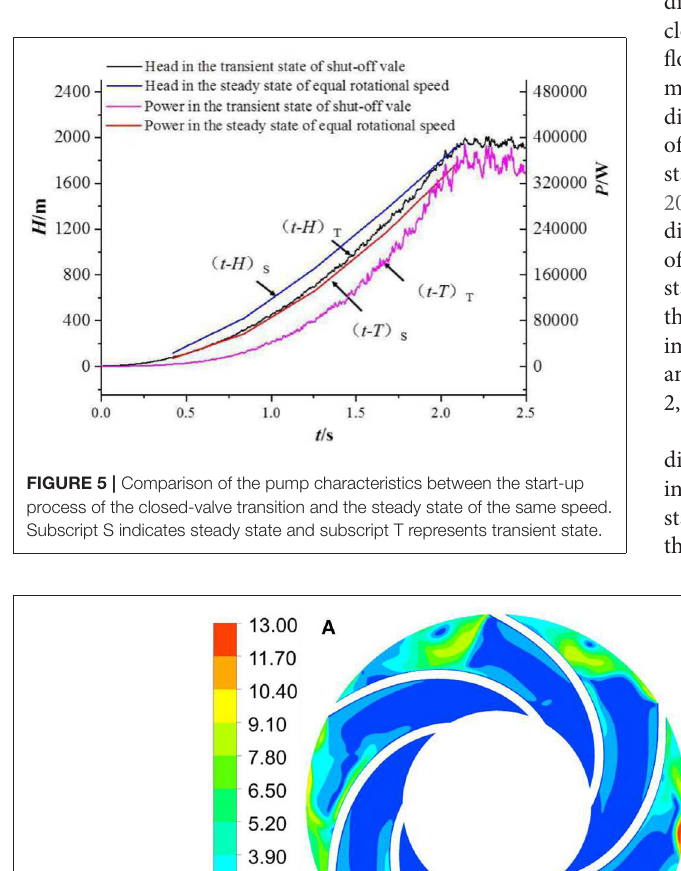
Frontiers in Energy Research |